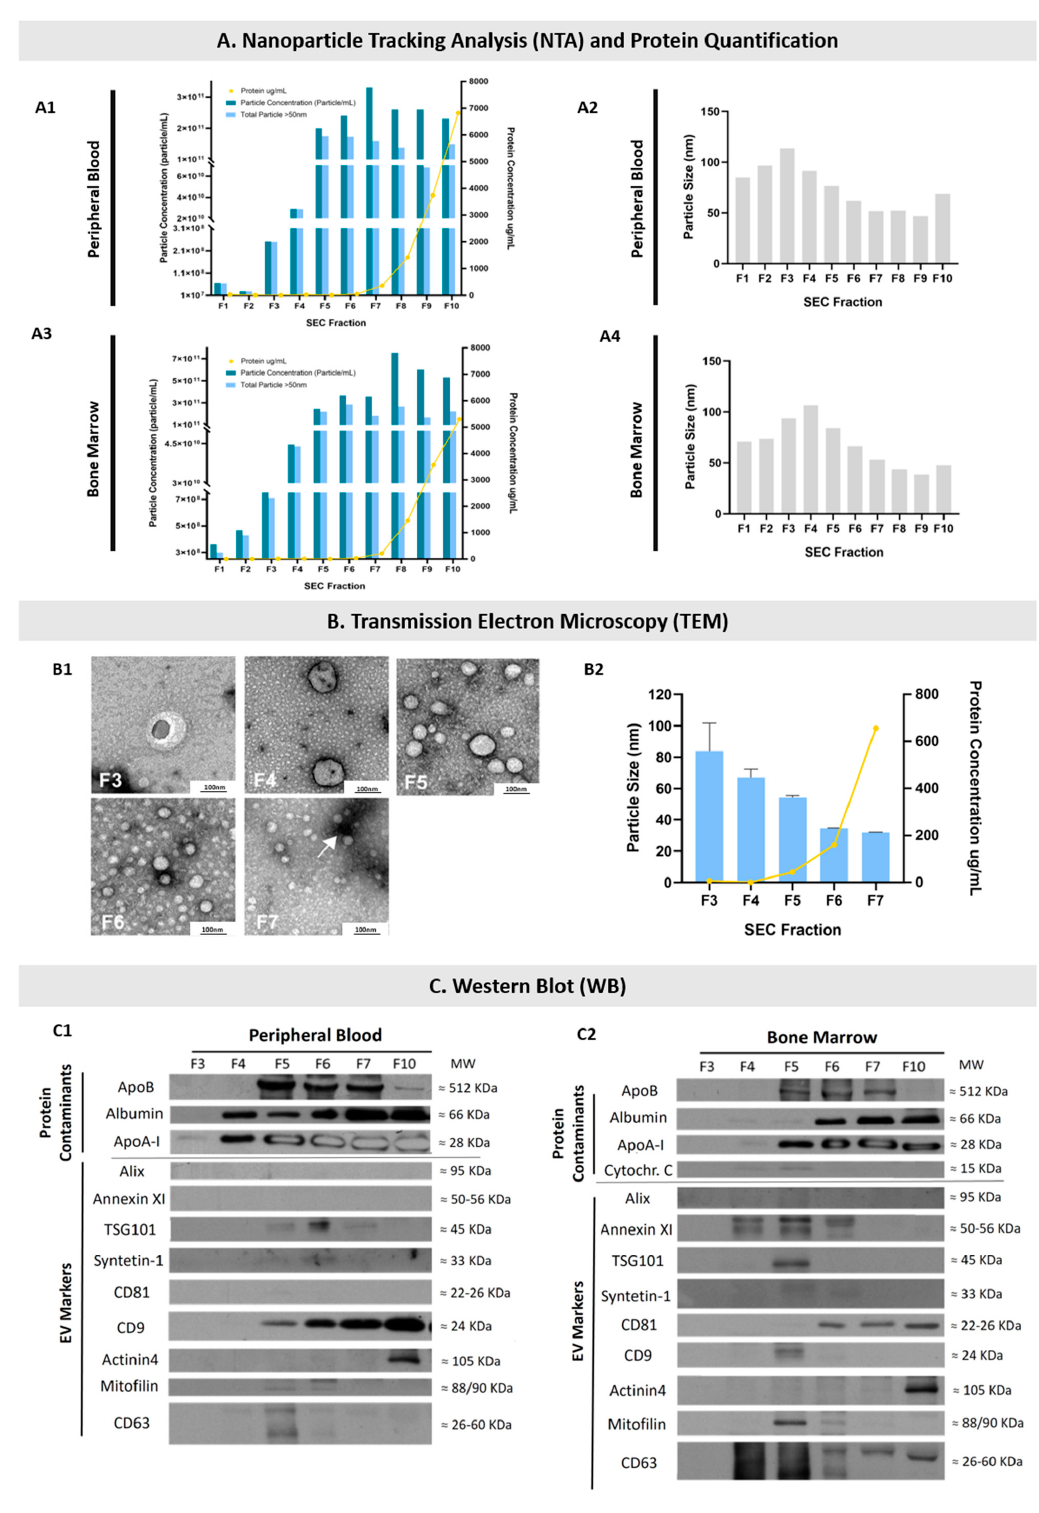
Figure 1. Characterization of the EVs isolated from peripheral blood (PB) and bone marrow (BM) samples by Size Exclusion Chromatography (SEC) and concentrated by ultrafiltration (UF). ( A ) NTA and protein quantification results suggest the presence of EVs from SEC fractions 3 to 6. Graphics